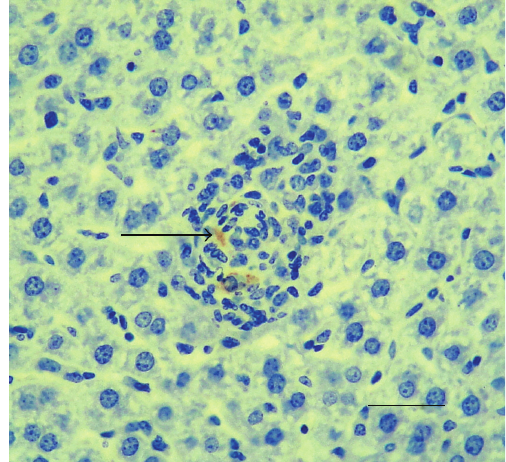
Figure 4: Liver of BALB/c mouse at 30 days of infection by Brucella ovis . The mouse was i.p. infected with 10 6 CFU of Brucella ovis ATCC25840. Microgranuloma with immunolabelled B. ovis in macrophages (arrow). IHC. Bar: 100 μ